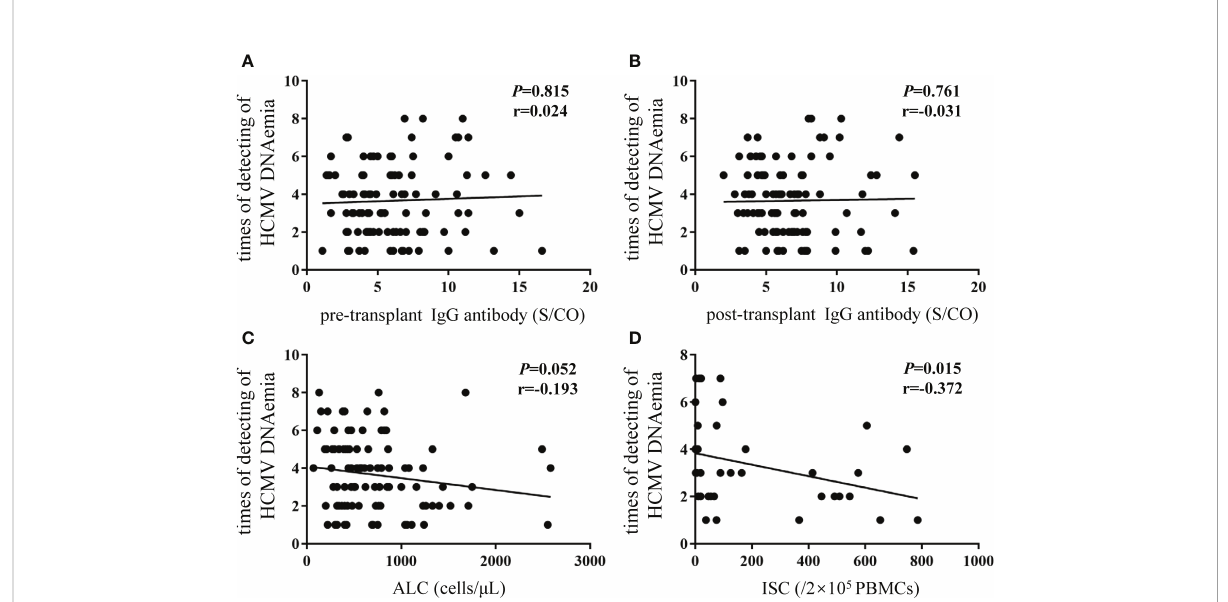
FIGURE 4 Correlations between duration of HCMV DNAemia and different biomarkers. Y-axis showed the times of continuously detecting HCMV DNA load every week representing the duration of HCMV DNAemia in recipients. (A) pre-transplant; (B) post-transplant HCMV IgG antibody concentrations; (C) ALC; (D) ISCs. The P value indicates level of signi fi cance and r, the correlation coef fi cient. HCMV, human cytomegalovirus; ALC, absolute lymphocyte count; ISCs, HCMV speci fi c IFN- g secreting cells.